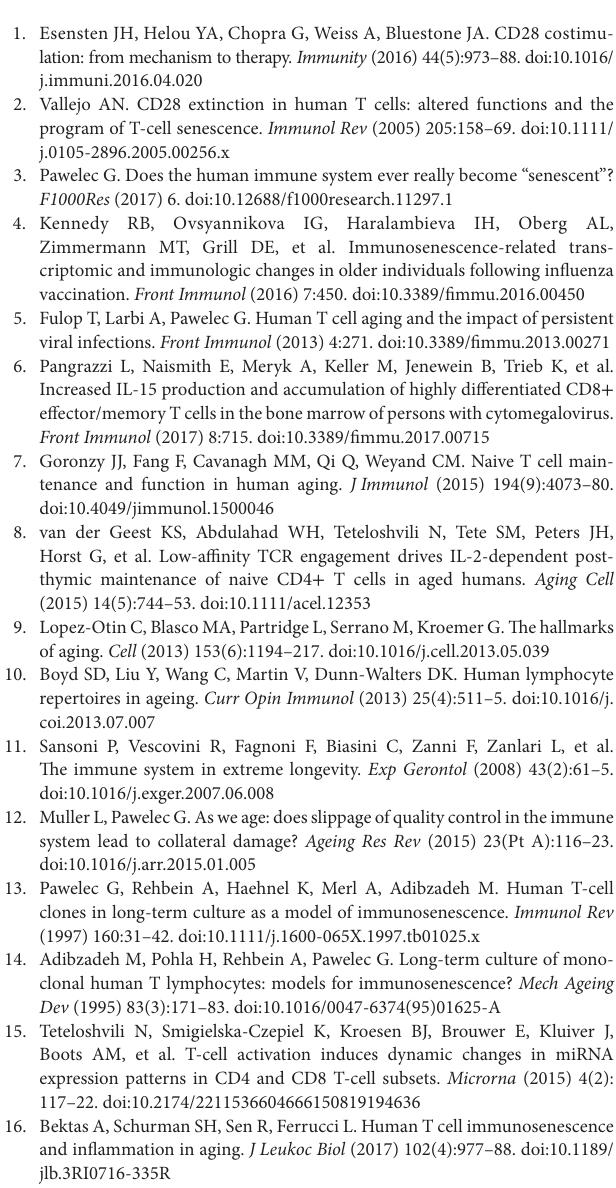
FigUre s3 | Loss of CD28 expression after 5 and 10 days culture with IL-15. Fluorescence-activated cell sorting-sorted naïve CD8 + CD45RO − CCR7 + CD28 + T cells were stained with proliferation dye to study CD28 expression after proliferation upon IL-15 stimulation (50 ng/ml). Proliferation of the naïve CD8 T cells was assessed after (a–F) 5 and (g–l) 10 days of culture. (a,g) Gate setting for the identification of the population doublings (PDs). Within the different PDs (B,e,h,K) expression of CD28 per generation, (c,i) CD28 expression per cell per generation, (D,F,J,l) CD45RO and (F,l) CCR7 expression was assessed. MFI = median fluorescence intensity. Significance (* p < 0.05, **p < 0.01) is depicted. N =